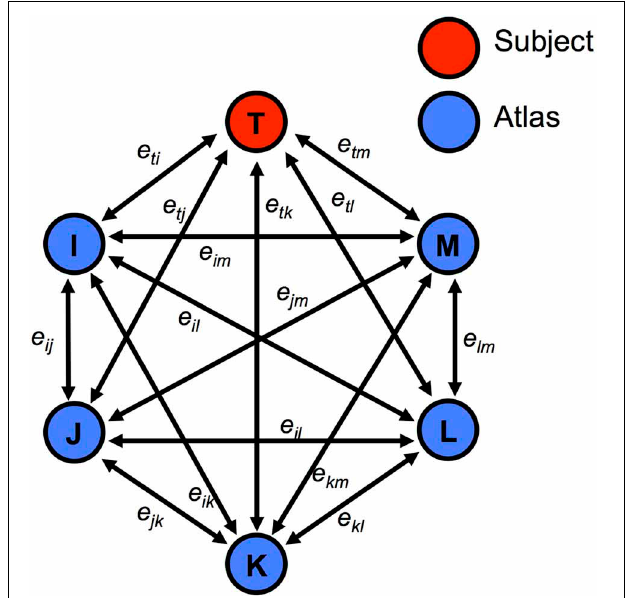
FIGURE 3 | Example of a graph with the subject T and atlases I, J, K, L and M. The graph is constructed based on the similarity measurements between image pairs.